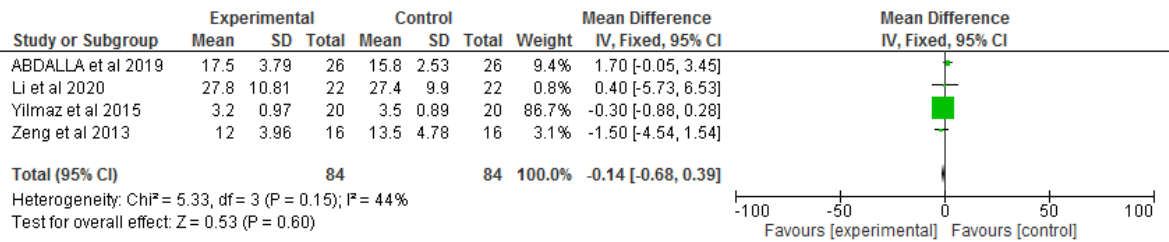
Figure 16. Forest plot for maxillary expansion between experiment and control after removing the studies lies outside the funnel.